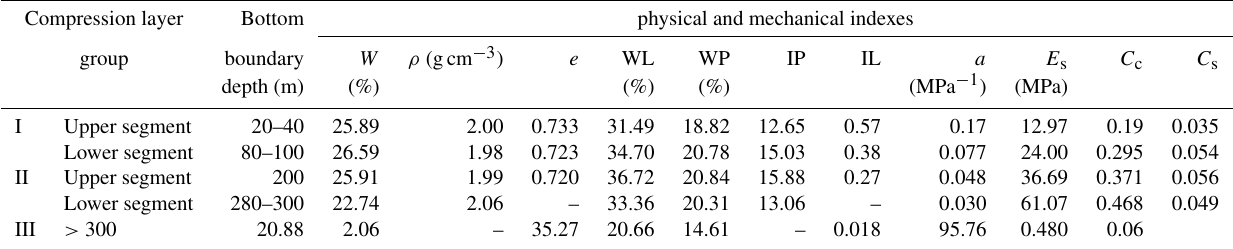
Table 1. Main physical and mechanical indexes of compressible strata in The Beijing plain.